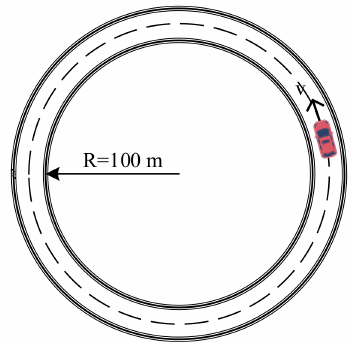
Figure 4. Const Radius Road Scenario.